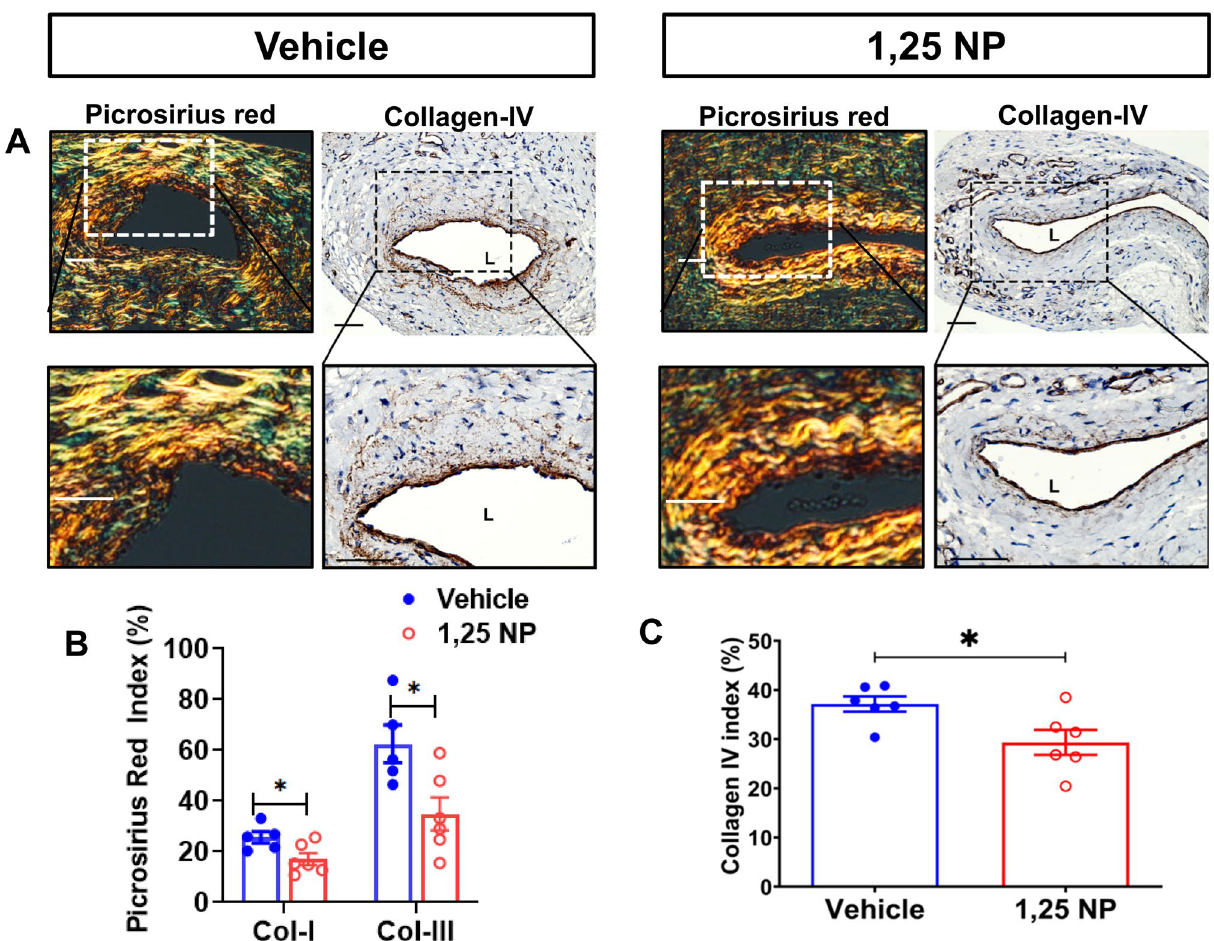
Figure 6. Fibrosis staining in 1,25 NP treated vessels. ( A ) Representative slides for Picrosirius red and collagen IV staining. Picrosirus red staining was visualized under polarized light, which distinguish collagen-I (yellow color) and collagen-III (green color). There is more collagen deposition in the media and neointimal area of vehicle controls compared to 1,25 NP treated vessels. ( B ) Semi-quantitative analysis showed a significant decrease in the average collagen-I and collagen-III ( p < 0.05) indices in 1,25 NP treated vessels compared to vehicle controls. ( C ) Semi-quantitative analysis showed a significant decrease in the average collagen IV ( p < 0.05) index in 1,25 NP treated vessels compared to vehicle controls. Each data point in the scatter plot bar graph represents the mean ± SEM of 5–6 AVFs. Unpaired t- test was performed. Significant differences are indicated * p < 0.05. ADV adventitia, L lumen. Scale bar is 50